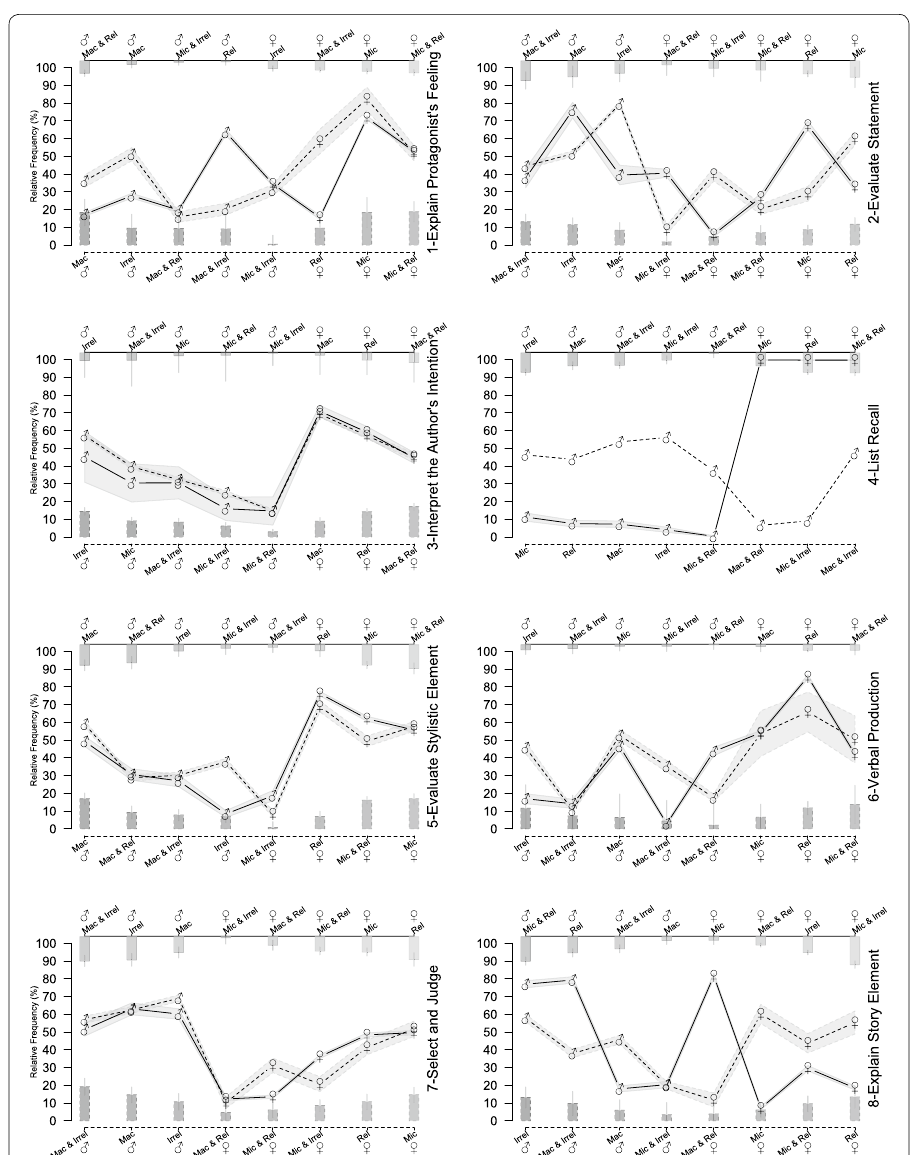
upper, solid abscissa and the solid line. Both lines are encapsulated by their 95% confi- dence